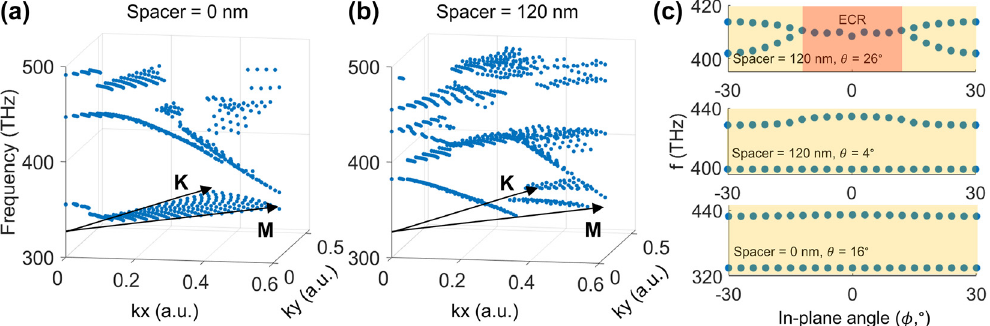
Figure 2: Full-wave simulations of non-Hermitian metasurfaces reveal non-trivial topology. Absorption peaks extracted from full-wave simulations while varying the out-of-plane angle ( 𝜃 ) from 0 ◦ to 30 ◦ and in-plane angle ( 𝜙 ) from 30 ◦ (M point) to 60 ◦ (K point) for (a) spacer = 0 nm and (b) spacer = 120 nm. For spacer = 120 nm, an exceptional concentric ring feature is observed. (c) Simulated mode frequencies of the 4 resonator system as the in-plane angle is tuned. For spacer = 120 nm and out-of plane incident angle of 26 ◦ , the system undergoes a transition from PT-symmetric (yellow) to exceptional concentric ring (ECR, red)